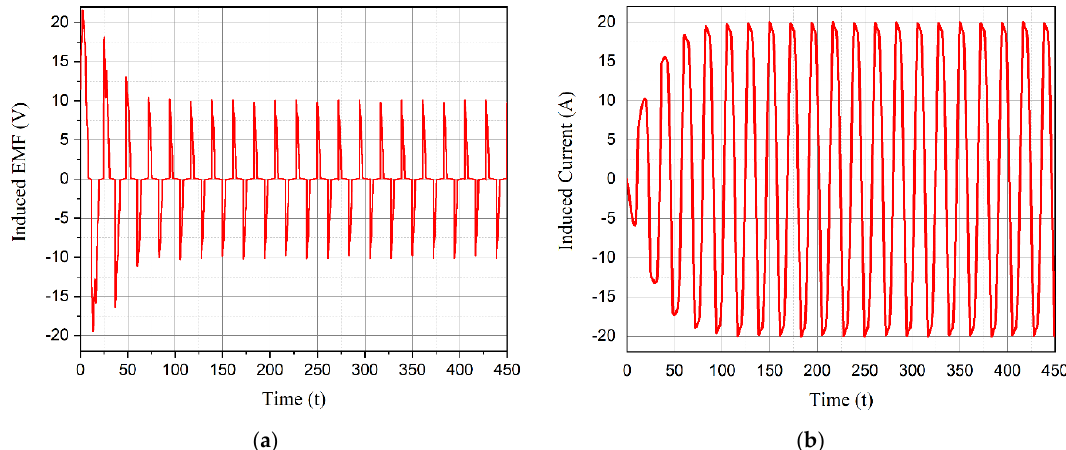
Figure 9. Induced voltage and current at the rotor harmonic winding: ( a ) Induced voltage; ( b ) Induced current.